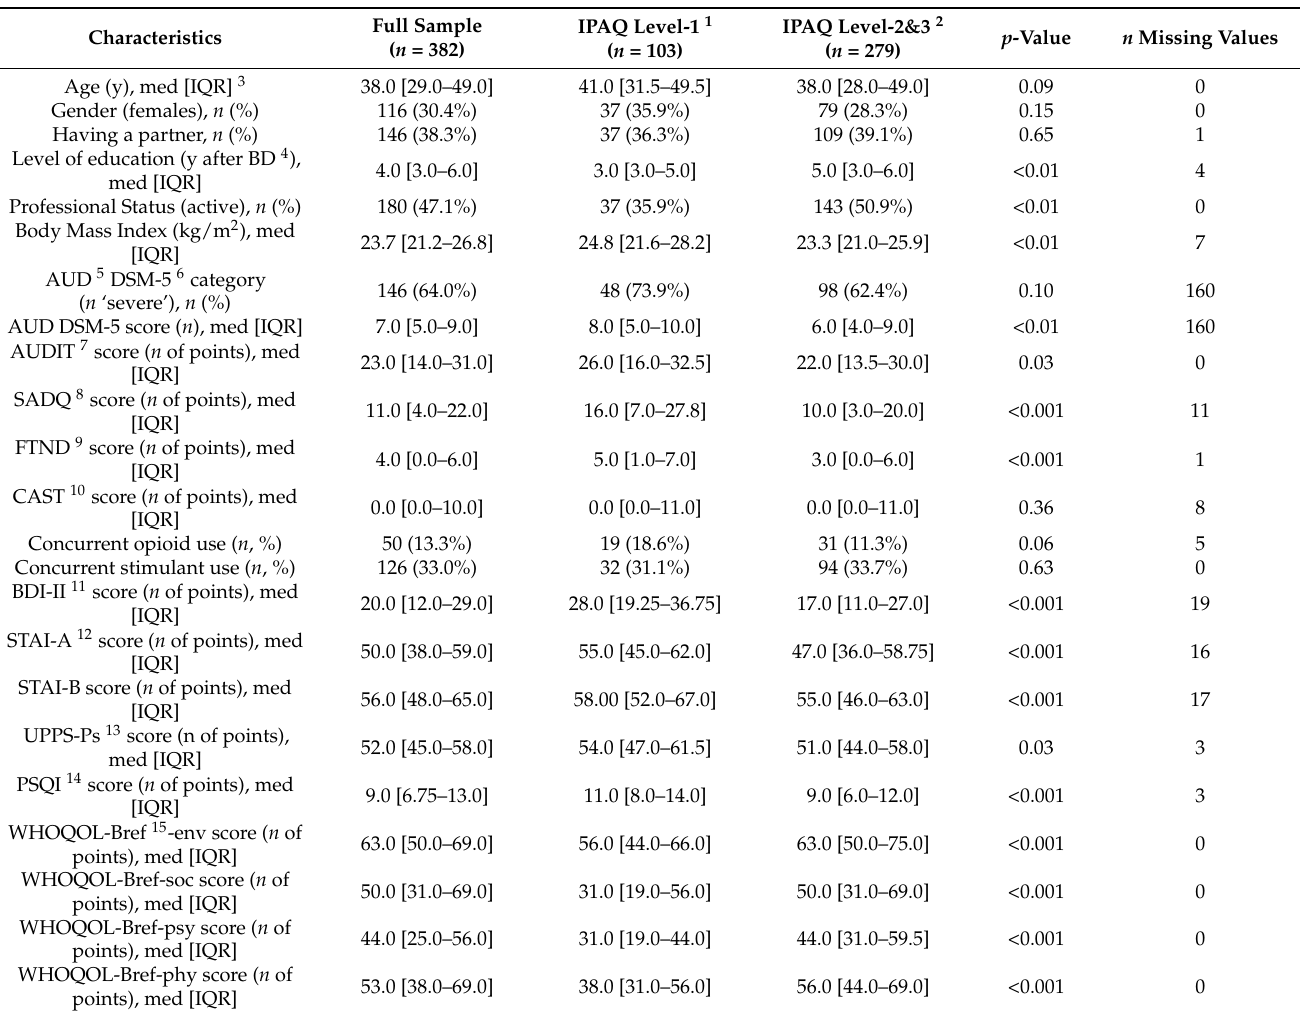
Table 1. Bivariable comparisons of the IPAQ level-1 group and the IPAQ level-2&3